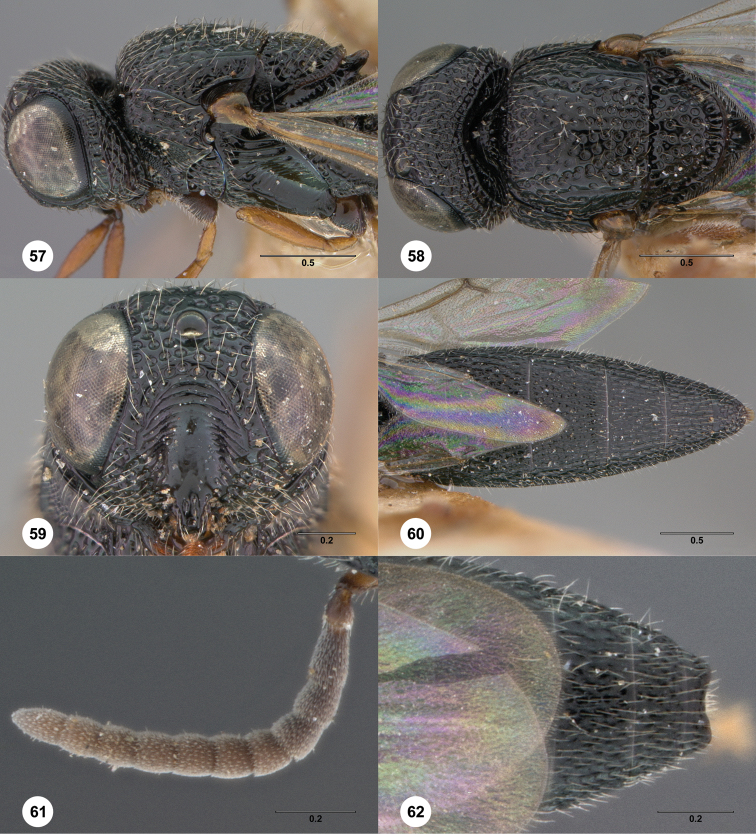
Oxyscelio conjuncti sp. n., paratype female (OSUC 429810) 57 Head and mesosoma, lateral view 58 Head and mesosoma, dorsal view 59 Head, anterior view 60 Metasoma, dorsal view. Paratype male (OSUC 429872) 61 Antenna 62 Metasoma, dorsal view. Morphbank38